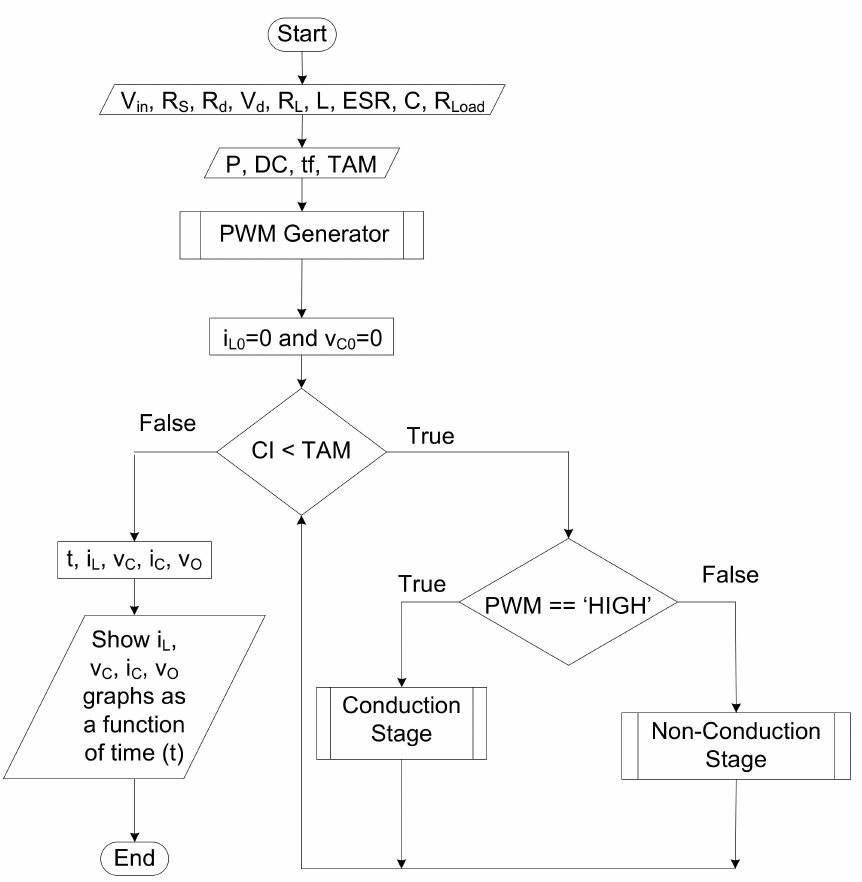
Figure 7. Main function flowchart. The conduction stage, non-conduction stage and PWM generator functions are represented in Figures 4–6,